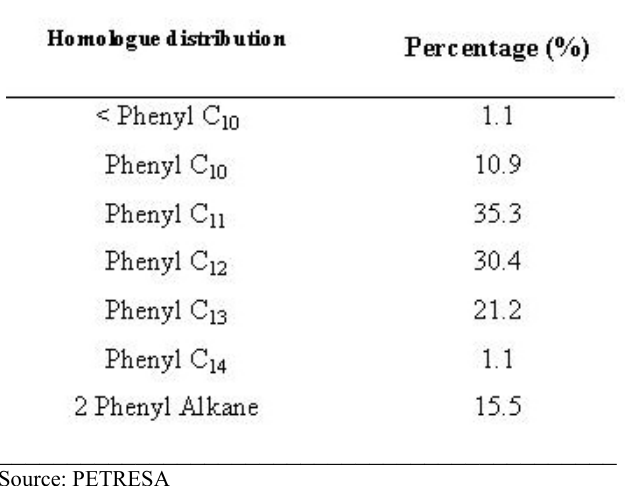
Homologue Composition of the Employed Commercial LAS